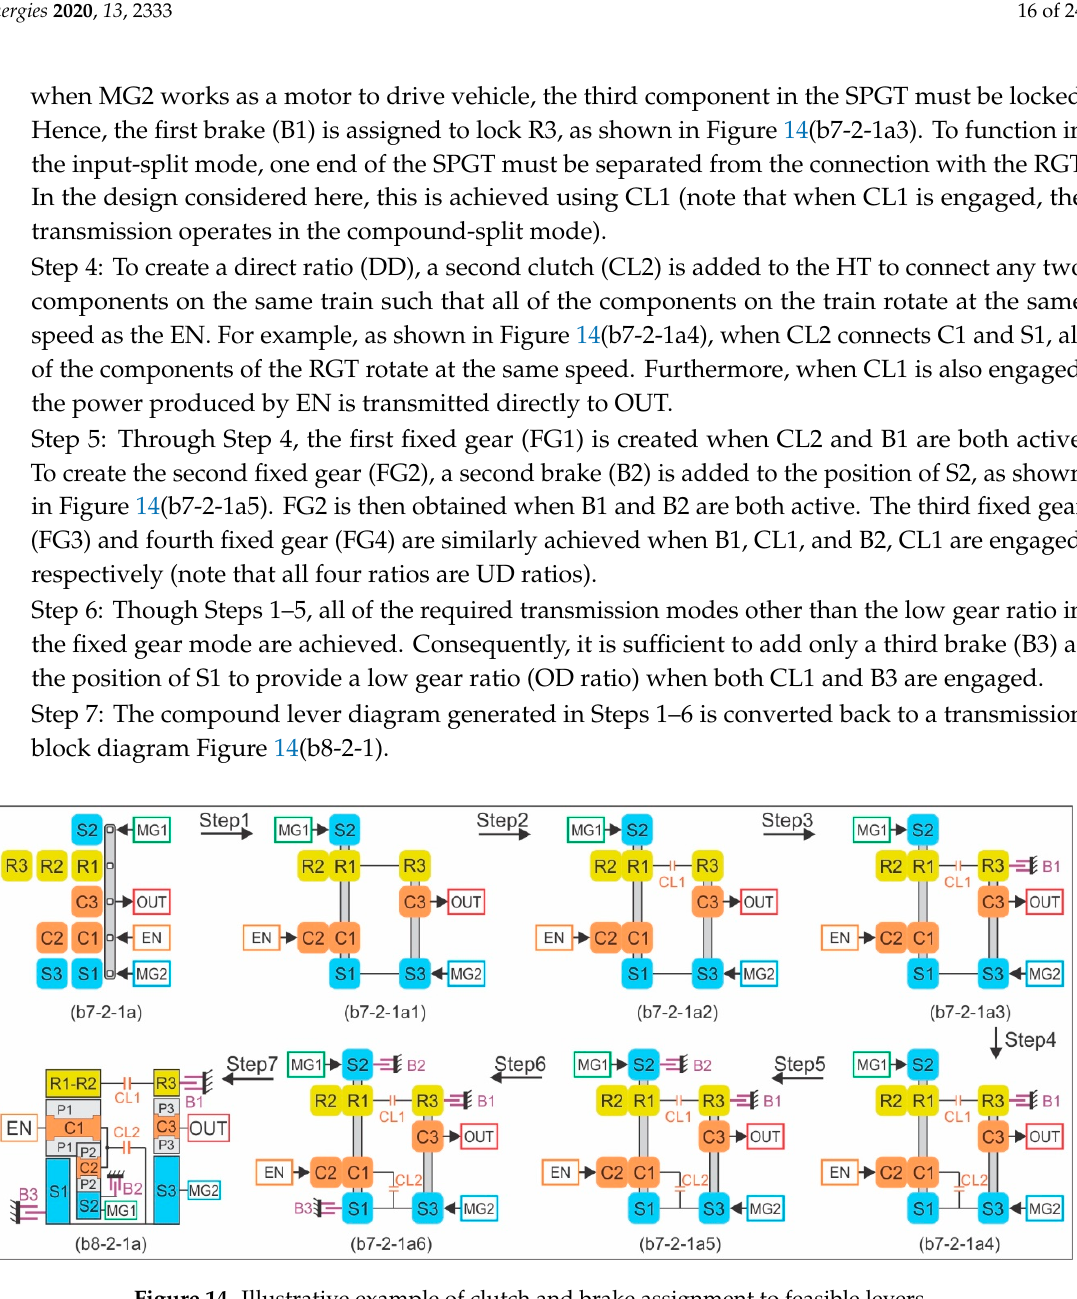
Figure 14. Illustrative example of clutch and brake assignment to feasible levers.